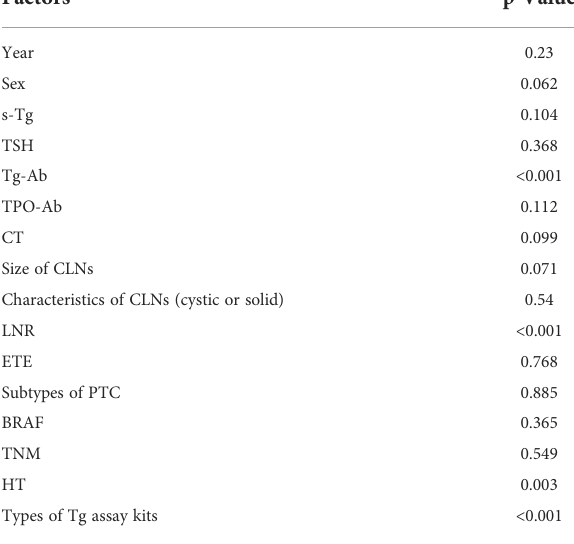
TABLE 6 Factors may in fl uence the level of